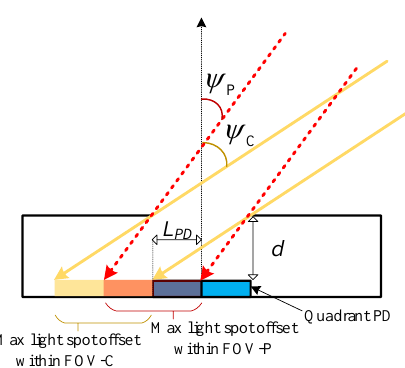
Figure 3. Difference between the FOV-C and the FOV-P of the QADA receiver.